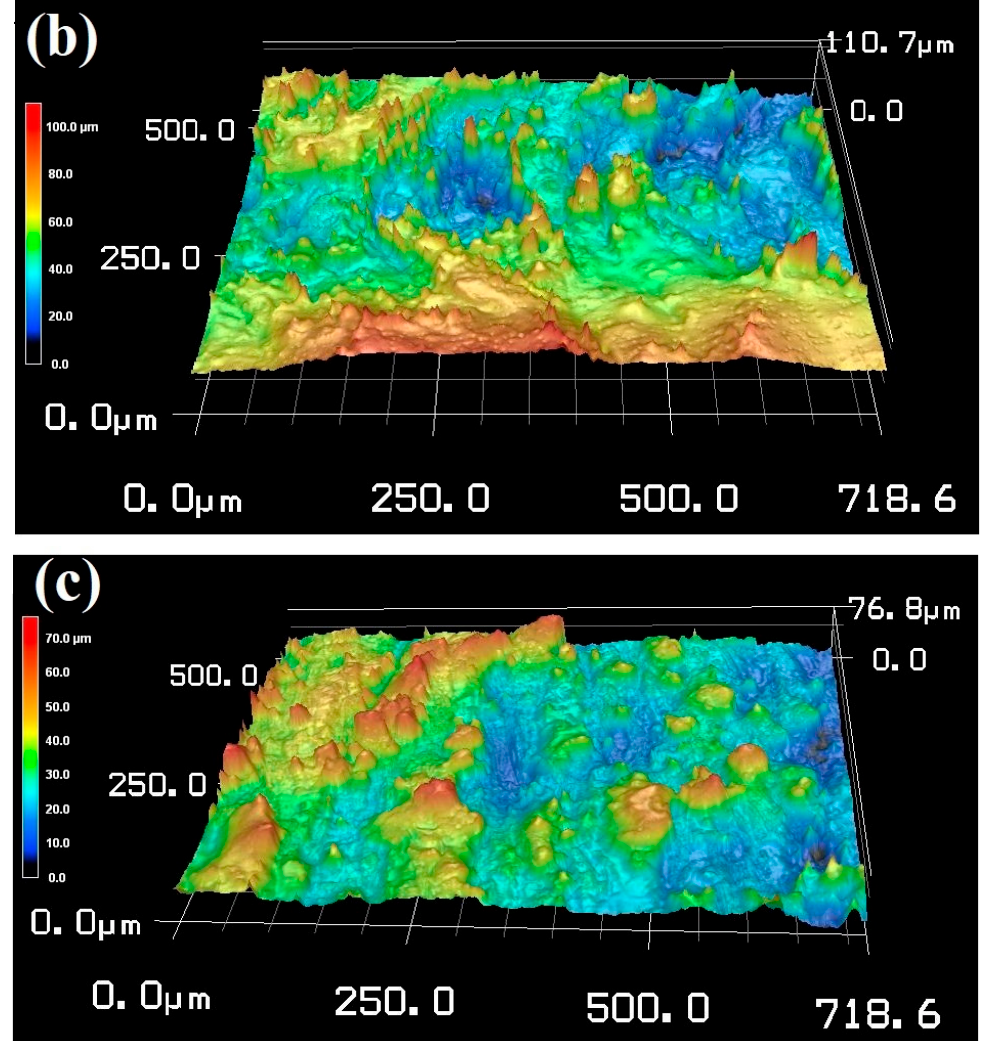
Figure 3. Surface topography and the corresponding surface roughness profile along the yellow lines measured by laser confocal scanning microscope. ( a ) T0.6, ( b ) T1, and ( c ) T1.4.